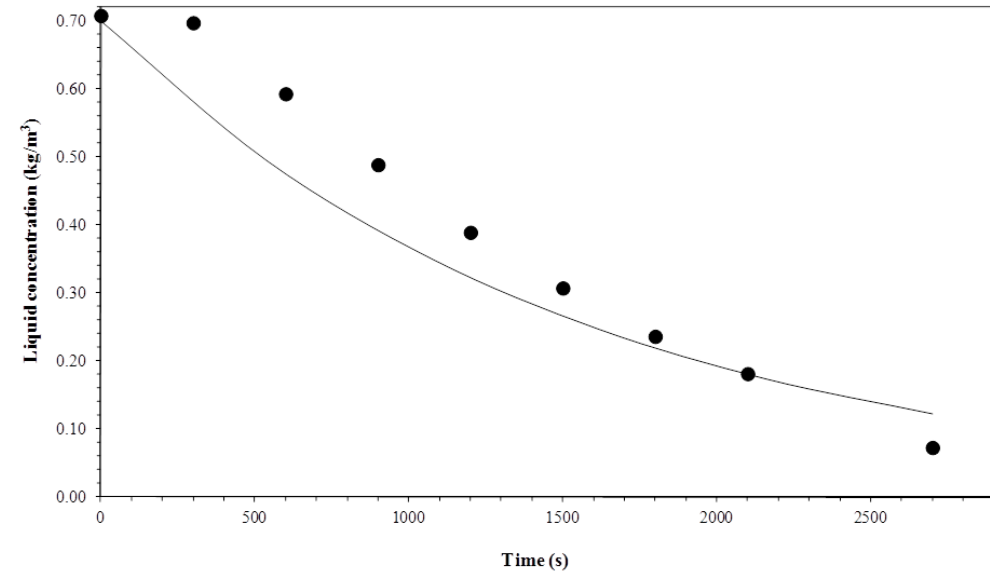
Figure 13. Comparison between experimental data and the model for a gas flow rate of 1 × 10 − 6 m 3 s − 1 and temperature of 15 °C.